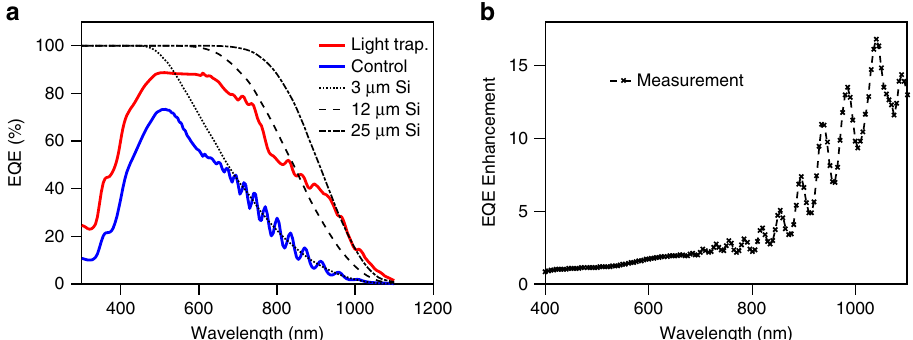
Fig. 3 EQE measurement. a EQE measurements of 500 μ m diameter control ( blue solid ) and light-trapping SPADs ( red solid ); dashed black lines correspond to theoretical absorption of 3, 12, and 25 μ m thick Si from left to right . b EQE enhancement: ratio of light-trapping SPAD EQE compared to control SPAD EQE at different